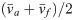
Stokes shift to F1(ε,n) using Bakhshiev’s equation (panel A), (v¯a+v¯f)/2 to F2(ε,n) using Kawski-Chamma-Viallet’s equation (panel B) for SAL-3 dissolved in different solvents (1—n-heptane, 2—n-hexane, 3 –chloroform, 4—butan-1-ol, 5—propan-2-ol, 6—ethanol, 7—DMF, 8—DMSO, 9—methanol, 10 –acetonitrile, 11—H2O). Black square–Em 1 (maximum of fluorescence ~ 330 nm), blue circle–Em 2 (maximum of fluorescence ~ 430 nm).